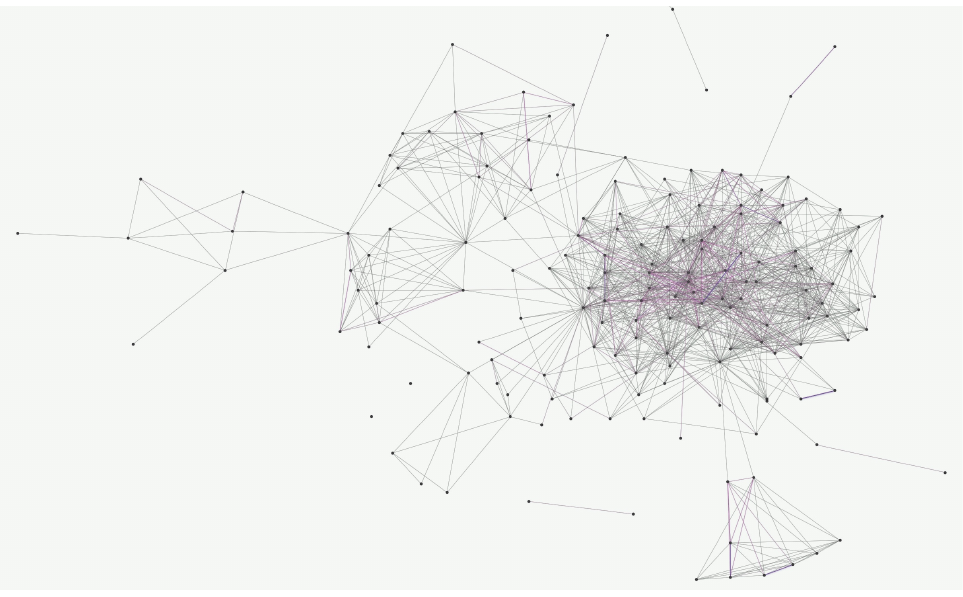
Mickaël Denié, Mon réseau: Facebook, mes amis et moi (blanc) , August 22, 2009 (photo: Flikr Commons).